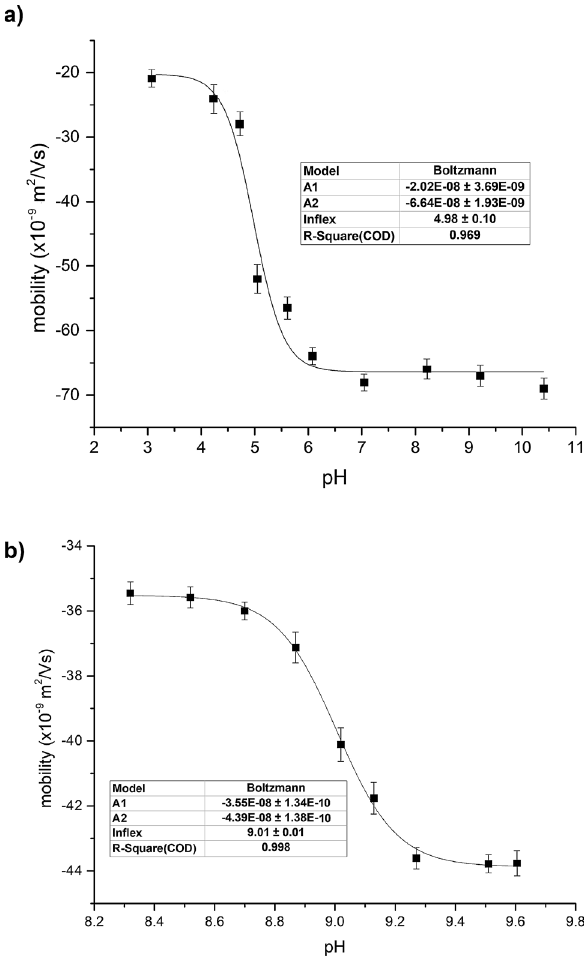
Figure 6. Dependence of effective electrophoretic mobility of ( a ) bilirubin-10-sulfonate (ranarubin) and ( b ) UCB. Background electrolytes 1–3, 6, 9–13 were used for the bilirubin-10-sulfonate studies; background electrolytes 3–5, 7, 8 for the UCB studies. Depicted points are the mean ± SD values of three experimental values. The position of the inflection points was determined using the numerical interpolation procedure using the standard Boltzmann sigmoidal function defined in the Origin software (Origin (Pro), Version 2016, OriginLab Corporation, Northampton, MA, USA Corporation, MA